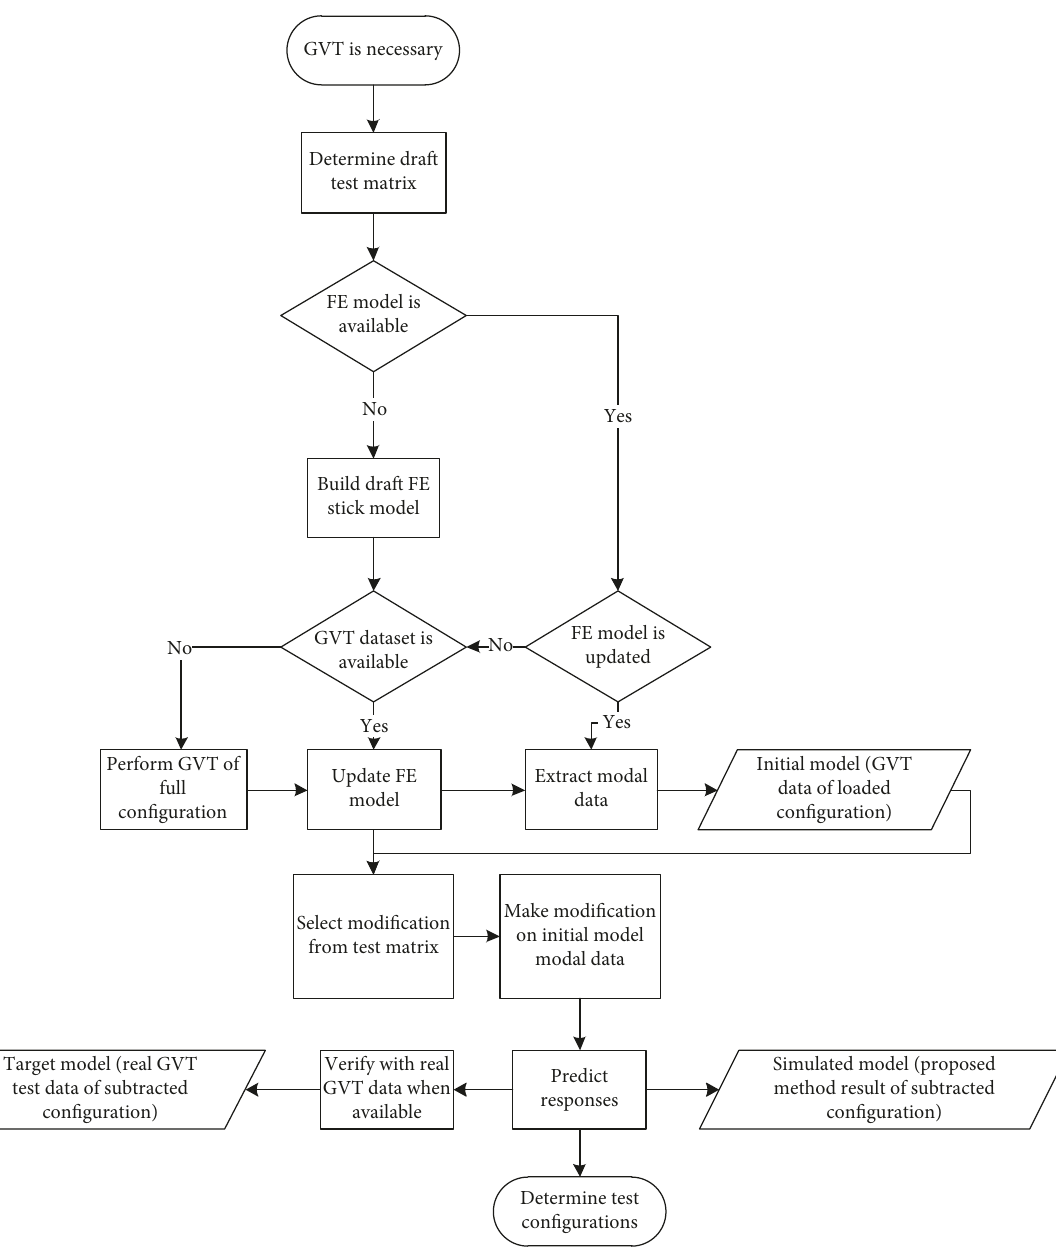
Figure 1: Flowchart and model